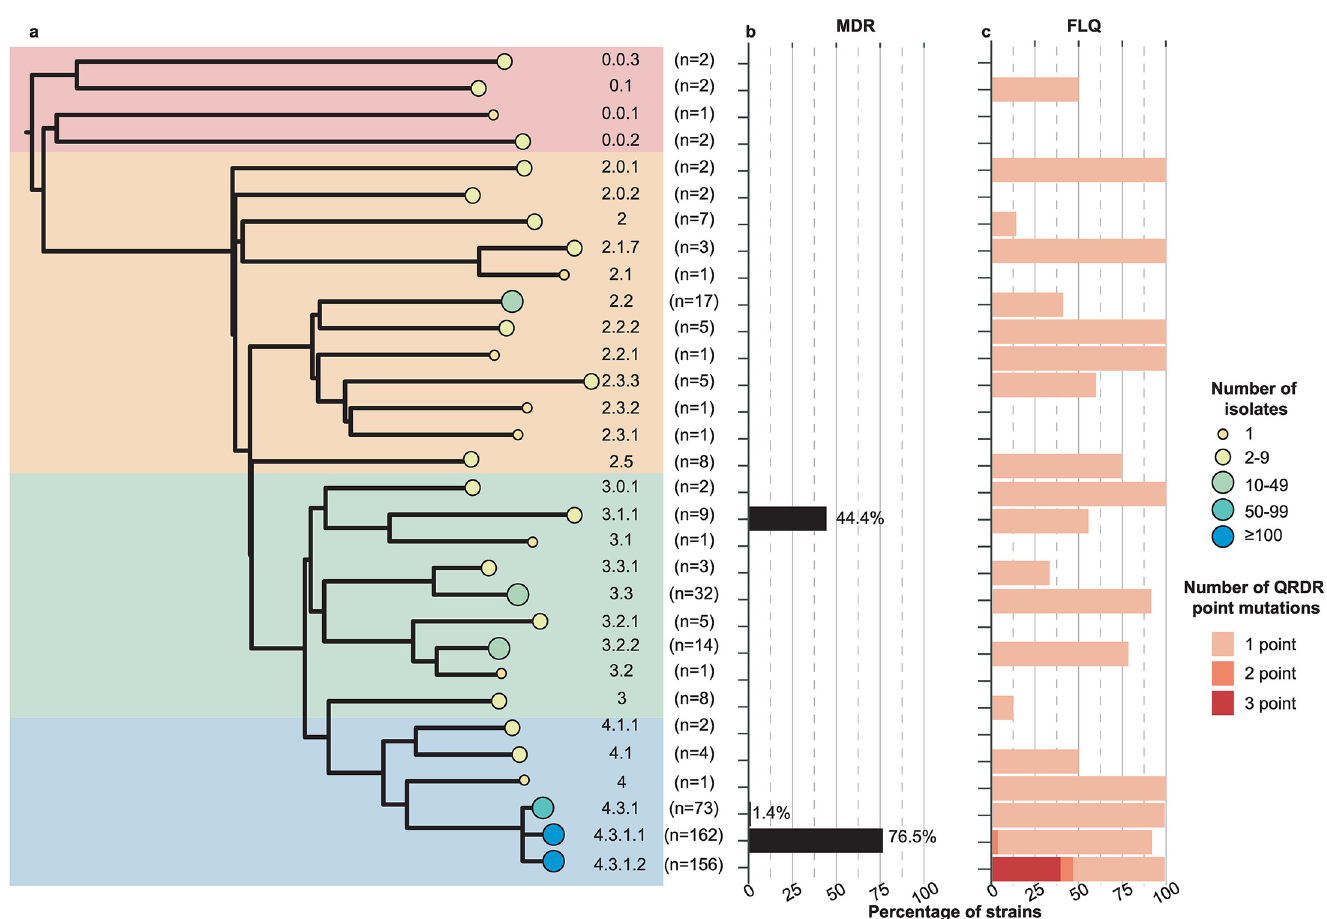
Fig 2. Membership of S . Typhi by genotypes and association with AMR. a) Population framework tree of the S . Typhi genotypes sequenced at PHE. Background shading indicates the primary clades. Tree tips indicate individual genotypes assigned by GenoTyphi; tip sizes and colours indicate number of isolates belonging to each genotype, these values (n) are also printed to the right. b) Frequency of MDR for each genotype (defined based on presence of AMR genes encoding resistance to the first line drugs ampicillin, trimethoprim-sulfamethoxazole, or chloramphenicol). c) Frequency of QRDR mutations by genotype.